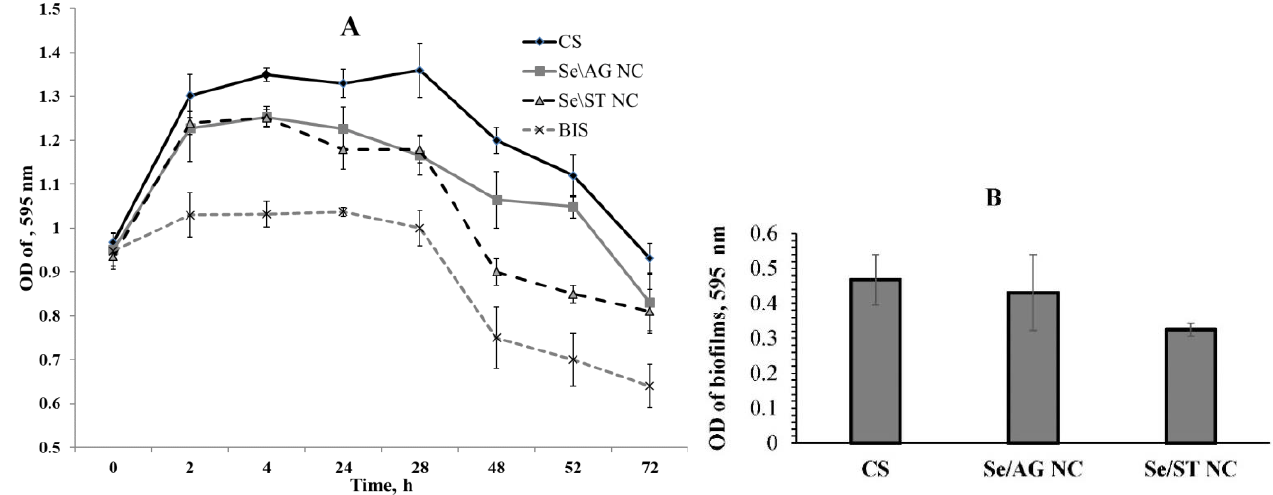
Figure 3. Effect of Se NC on the growth ( A ) and biofilms ( B ) of Clavibacter sepedonicus . OD—optical density.